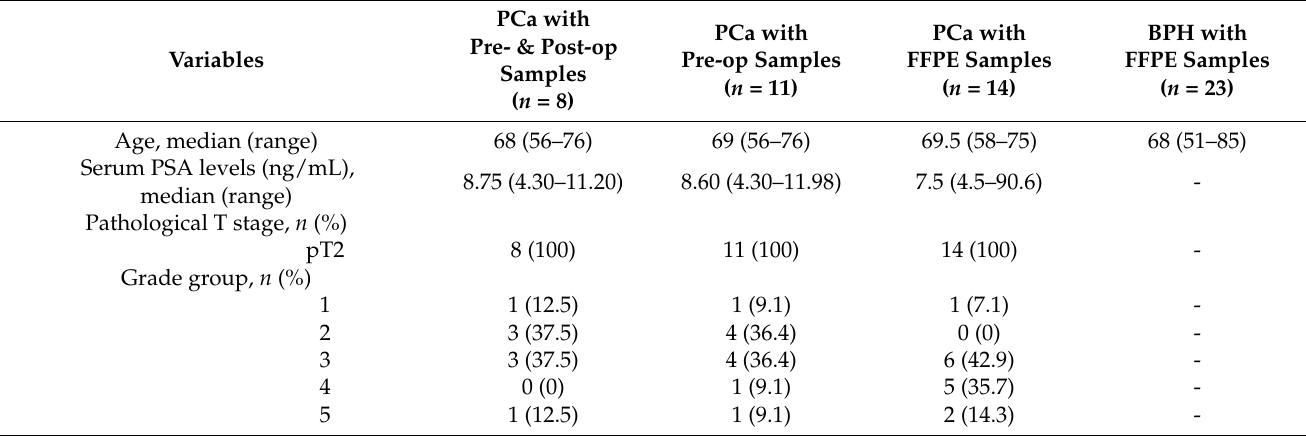
Table 1. Clinicopathological characteristics of prostate cancer (PCa) and benign prostate hyperplasia (BPH)